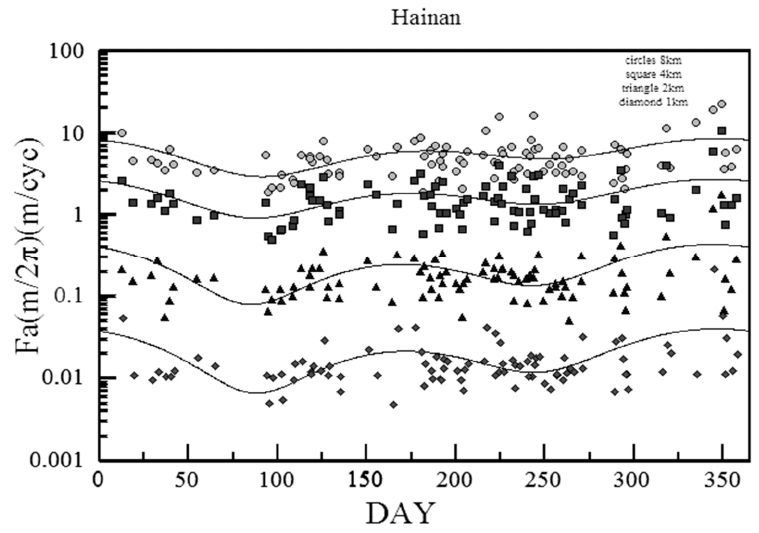
Figure 2. Seasonal variations of F a (m) and their MMSE fits at Beijing ( top ), Hefei ( middle ) and Hainan ( bottom ).